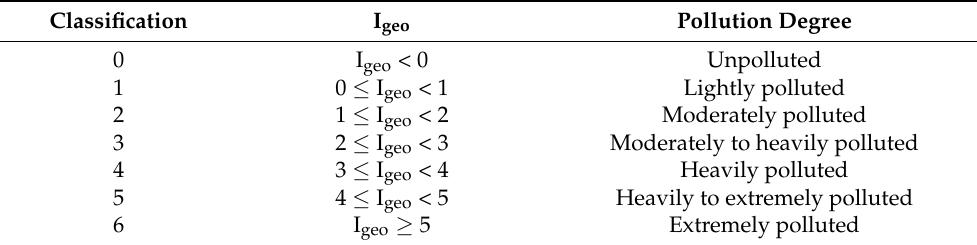
Table 1. Classification of I geo .